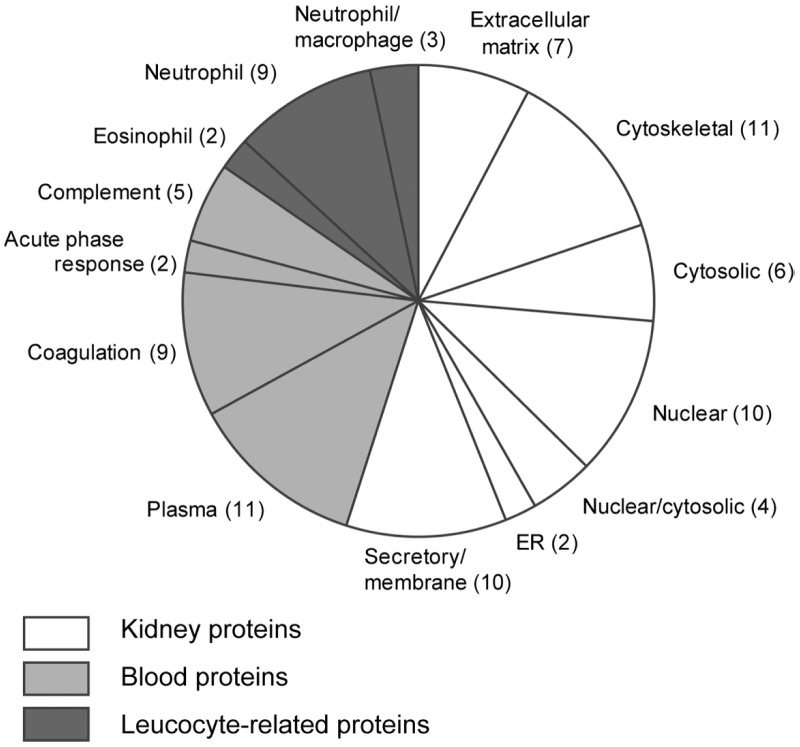
Classification of protein components detected in CaOx kidney stones.Extracts from 9 individual CaOx stone samples were examined separately by shotgun analysis as shown in Fig. 3, and the results in detail were presented in Table S1. As summarized in this figure, a total of 92 proteins were identified in this analysis. These proteins could be classified into three major groups according to their possible origins, i. e., kidney proteins, blood proteins and leucocyte-related proteins. Proteins in each group were further classified into subgroups.